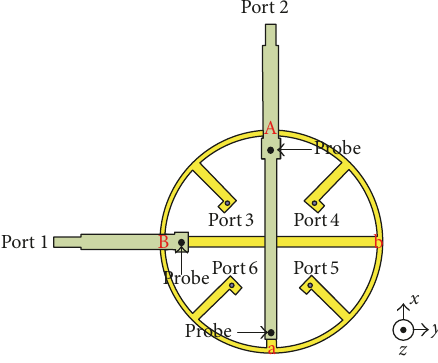
Figure 1: Layout of the hybrid feeding network.